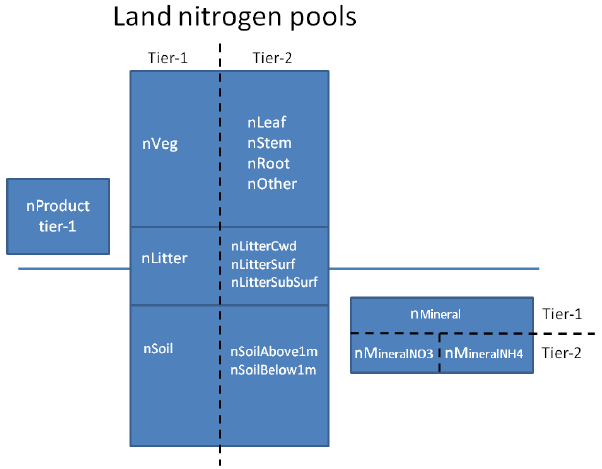
Figure 7. Requested tier-1 and tier-2 variables representing land nitrogen pools.